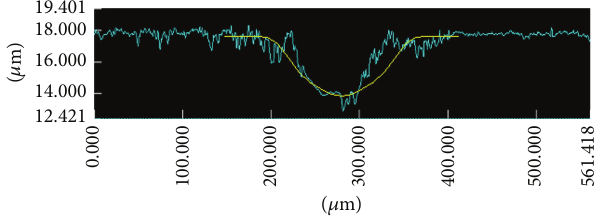
Figure 4: The cross section of crater from experiment (blue line) and theoretical calculation (yellow line). Target: tungsten; laser wavelength 355 nm; fluence 10J/cm 2 ; 50 laser pulses.